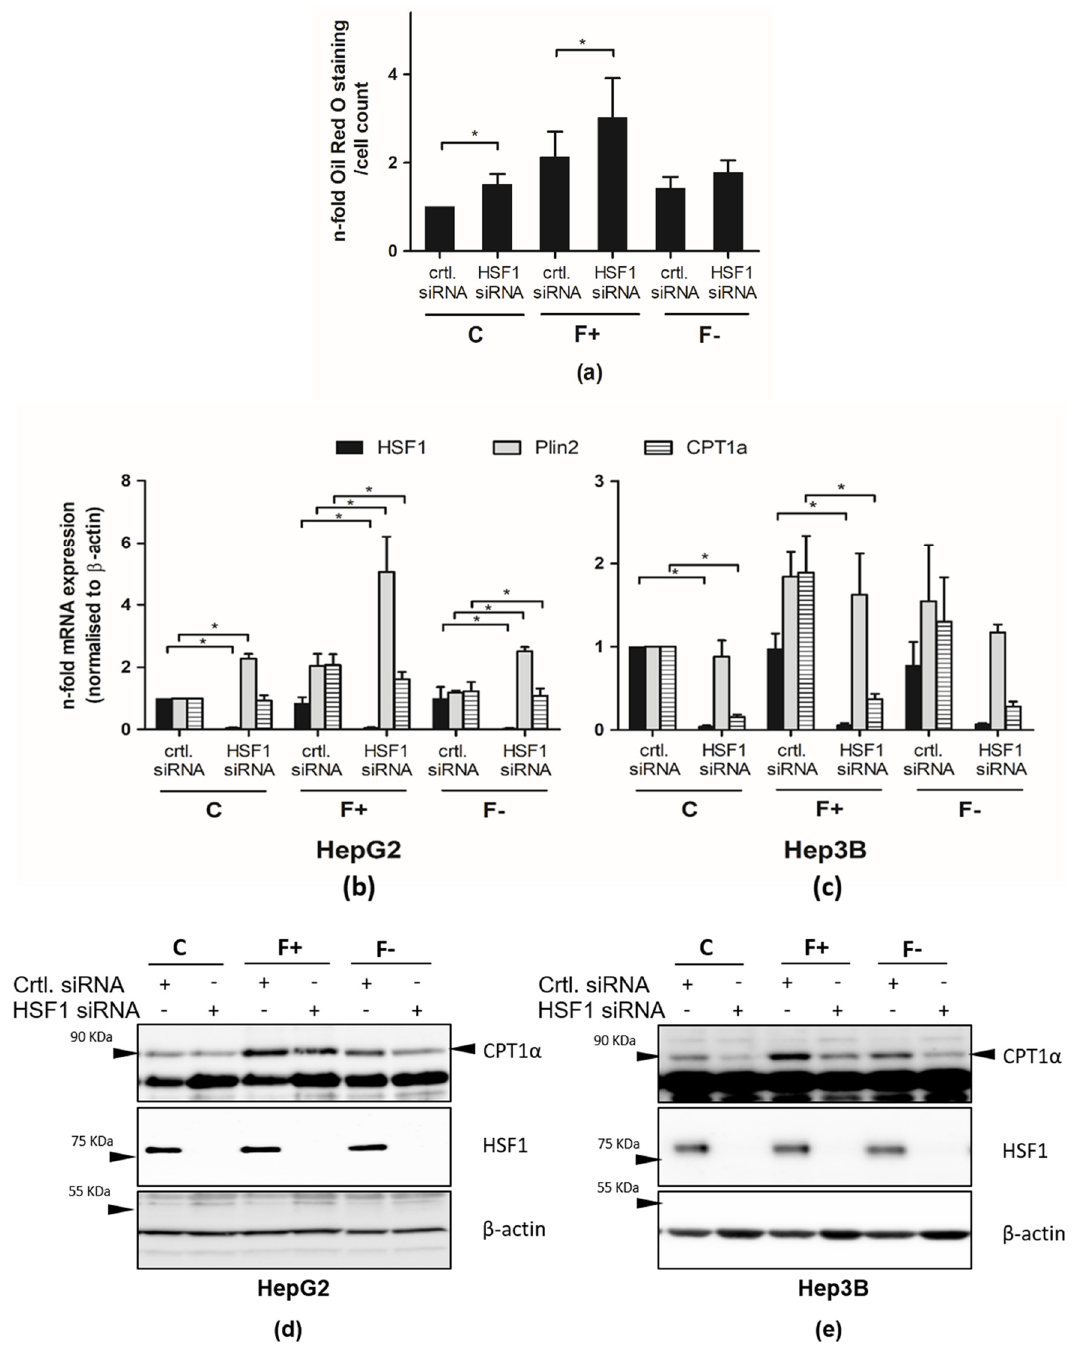
Figure 6. Knockdown of HSF1 increases fat accumulation in HepG2 and Hep3b and decreases CPT1a expression. HepG2 and Hep3B cells were transfected with the indicated siRNA and cultured with control (C) or PA/OA medium for 96 h to induce fat accumulation. Afterward, PA/OA medium-cultured cells were treated with a control medium (F-) or continually with PA/OA medium (F+). Oil-Red-O staining ( a ) of HepG2, mRNA expression of indicated genes in HepG2 and Hep3b cells ( b , c ) and protein expression of the indicated genes ( d , e ) are shown. For normalization, β-actin expression was analyzed. The figure depicts the mean values of three independent experiments performed in duplicates ± S.D. * p -values < 0.05. For protein expression, representative results of 4 independent experiments are shown.